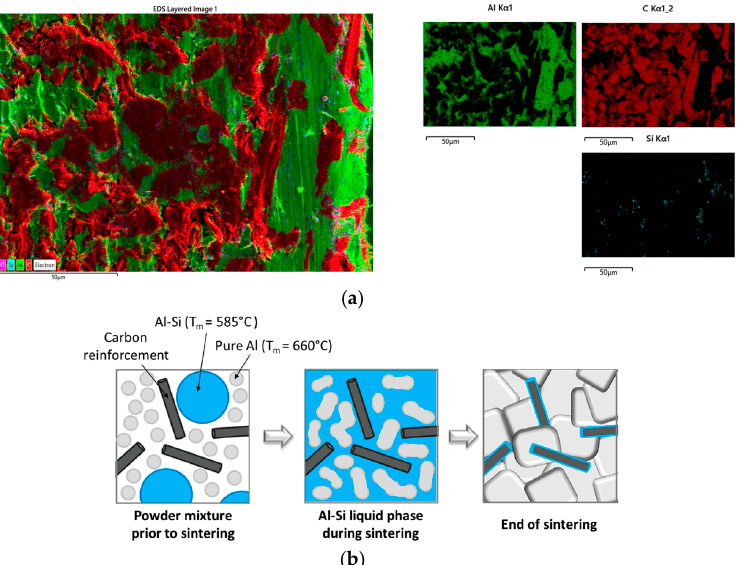
Figure 7. ( a ) EDS mapping was performed on a cross-section of a reference PM adapter, showing the distribution of Al, C and Si. ( b ) A Si-rich phase is expected due to the addition of eutectic Al11.3%Si powder in the sintering process (from [ 16 ] ). Materials 2022 , 15 , x FOR PEER REVIEW